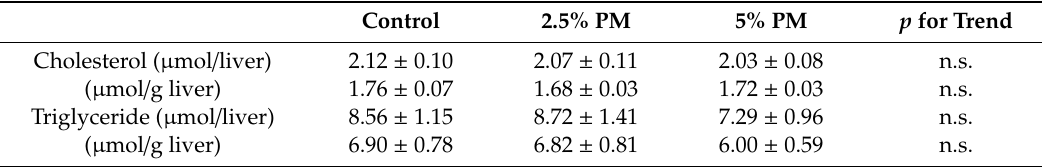
Table 8. Liver lipid